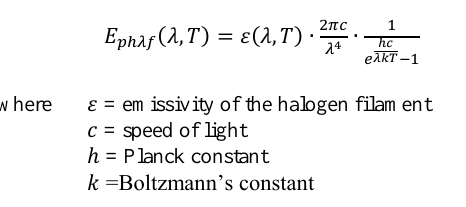
Figure 7. Block diagram for radiance calibration (Jagpal, 2011) The spectral emittance of the halogen is a function of wavelength , and temperature , and is given by